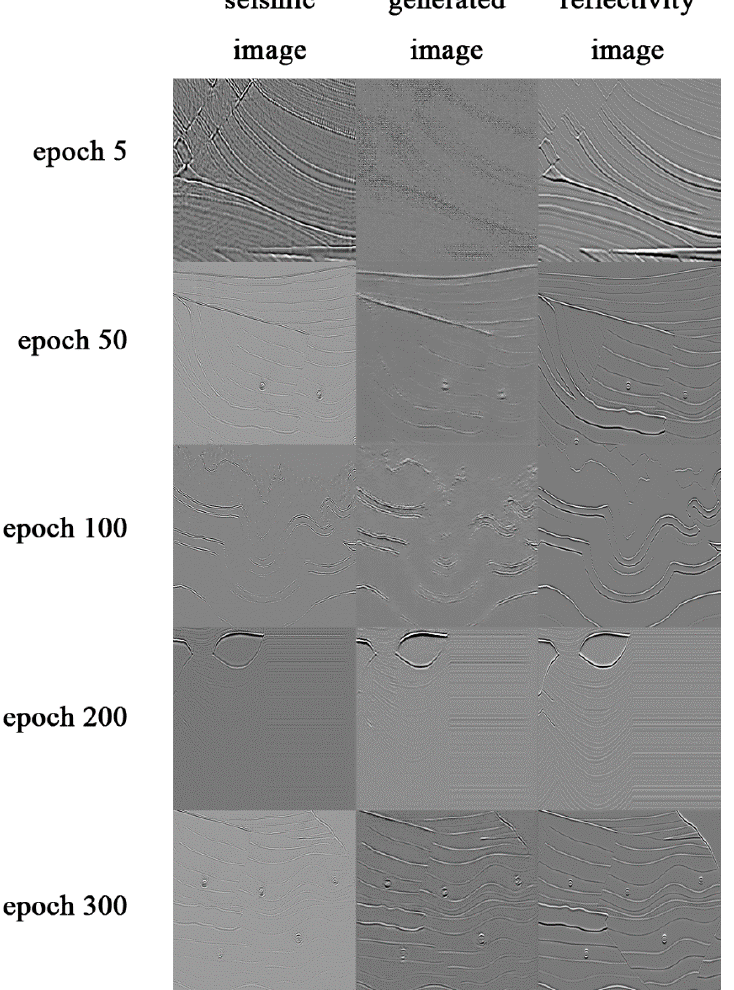
Figure 7. The intermediate results in the process of training. The GAN begins by learning the structure of the image. Then, the details are learned step by step. After about 300 epochs, the generator can depict the fine structure of the